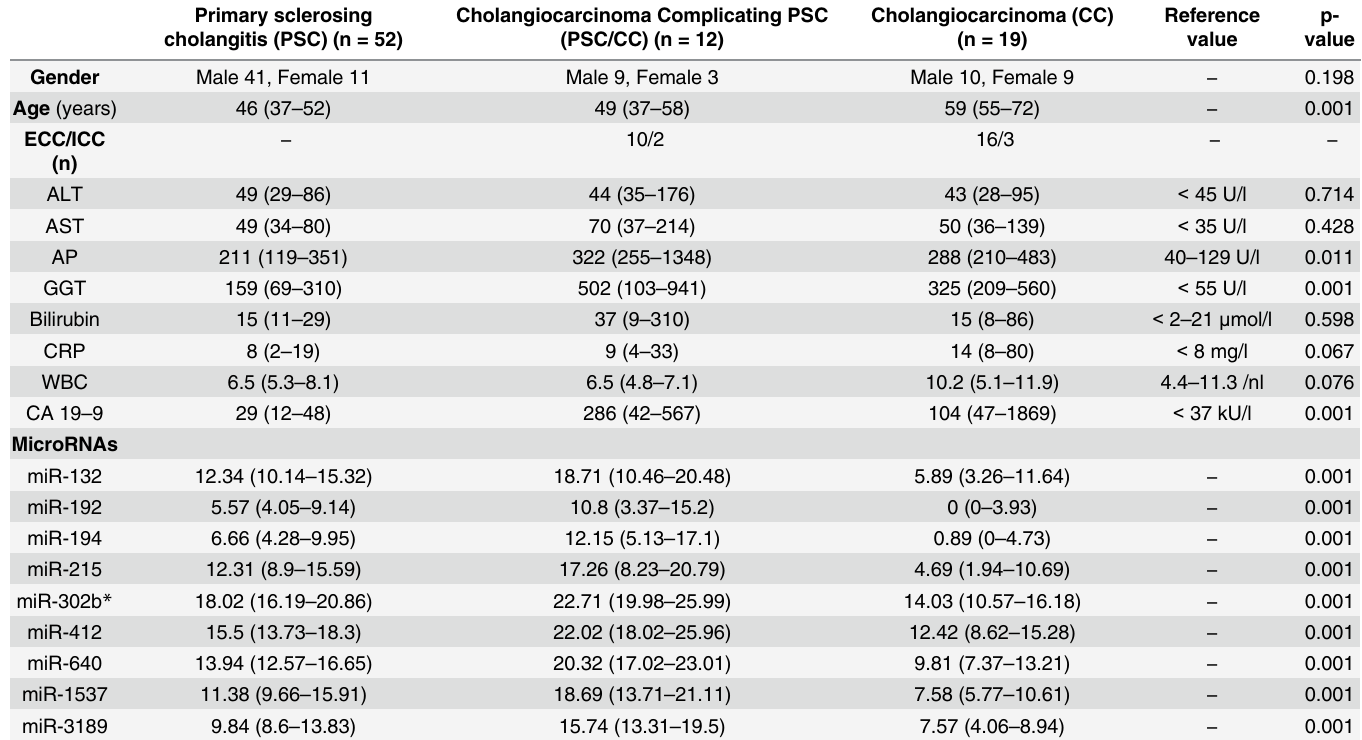
Table 3. Clinical features, demographics and laboratory values of the patient cohorts. The aforementioned parameters are presented in Table 3 (Bile). Patients with primary sclerosing cholangitis (PSC) and cholangiocarcinoma (CC) were compared regarding demographics, laboratory and microRNA (miRNA) values. Data were expressed as number or median with interquartile range (IQR). ECC: extrahepatic cholangiocarcinoma; ICC: intrahepatic cholan- giocarcinoma; ALT: alanine aminotransferase; AST: aspartate aminotransferase; AP: alkaline phosphatase; GGT: gamma-glutamyl transferase; CRP: C- reactive protein; WBC: white blood cells; CA 19 – 9: carbohydrate antigen 19 – 9. Primary sclerosing cholangitis (PSC) (n =